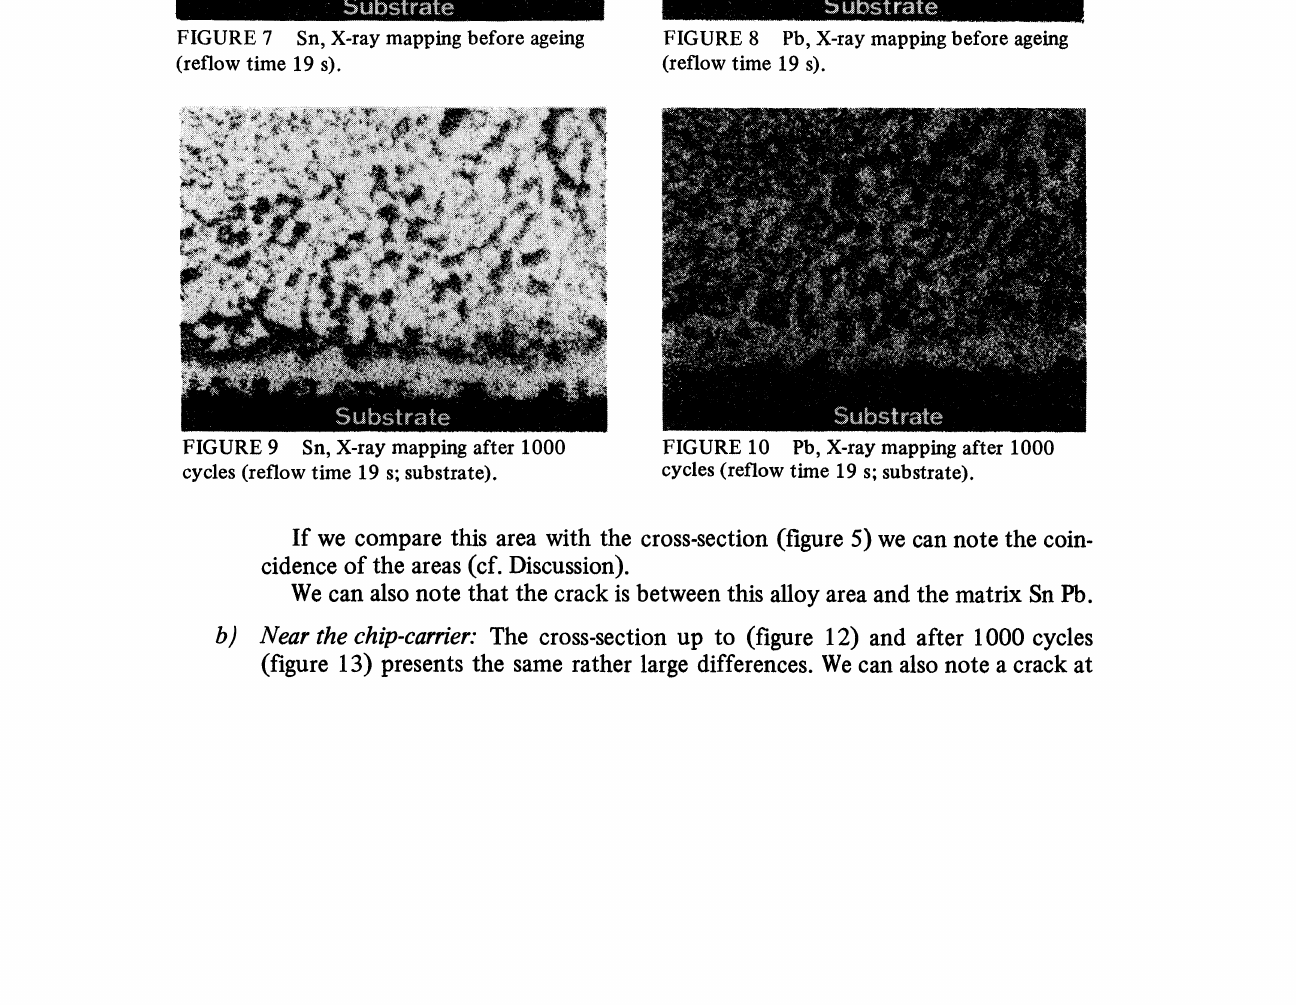
FIGURE 8 Pb, X-ray mapping before ageing (reflow time 19 s).